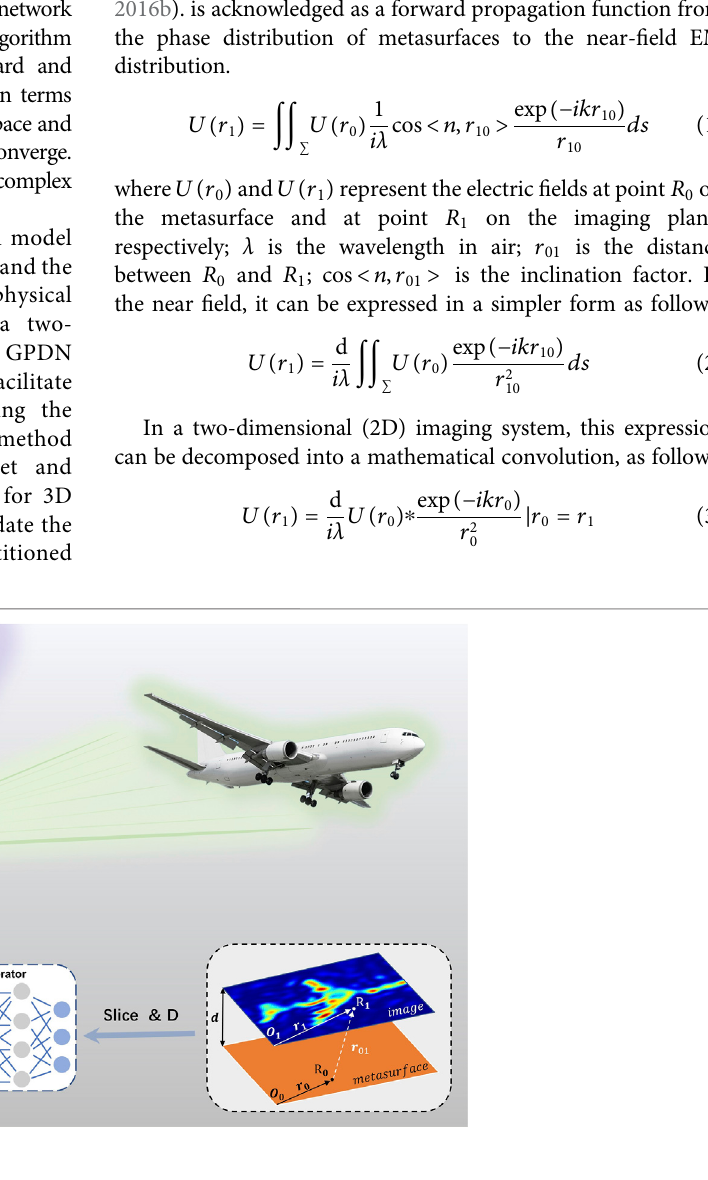
FIGURE 1 | Schematic illustration of holographic imaging